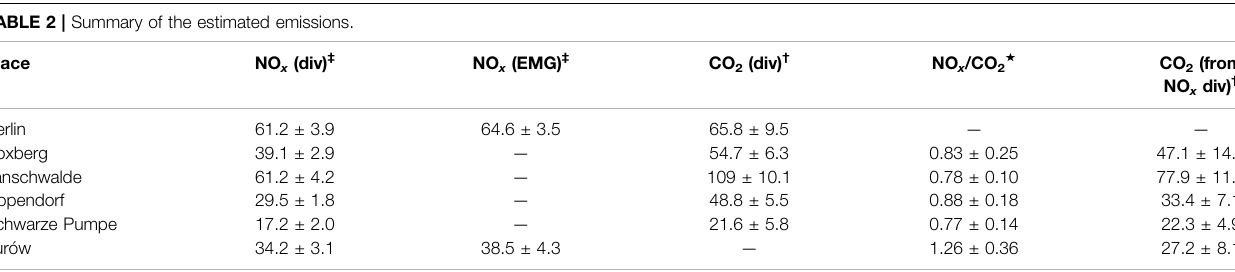
TABLE 2 | Summary of the estimated emissions.